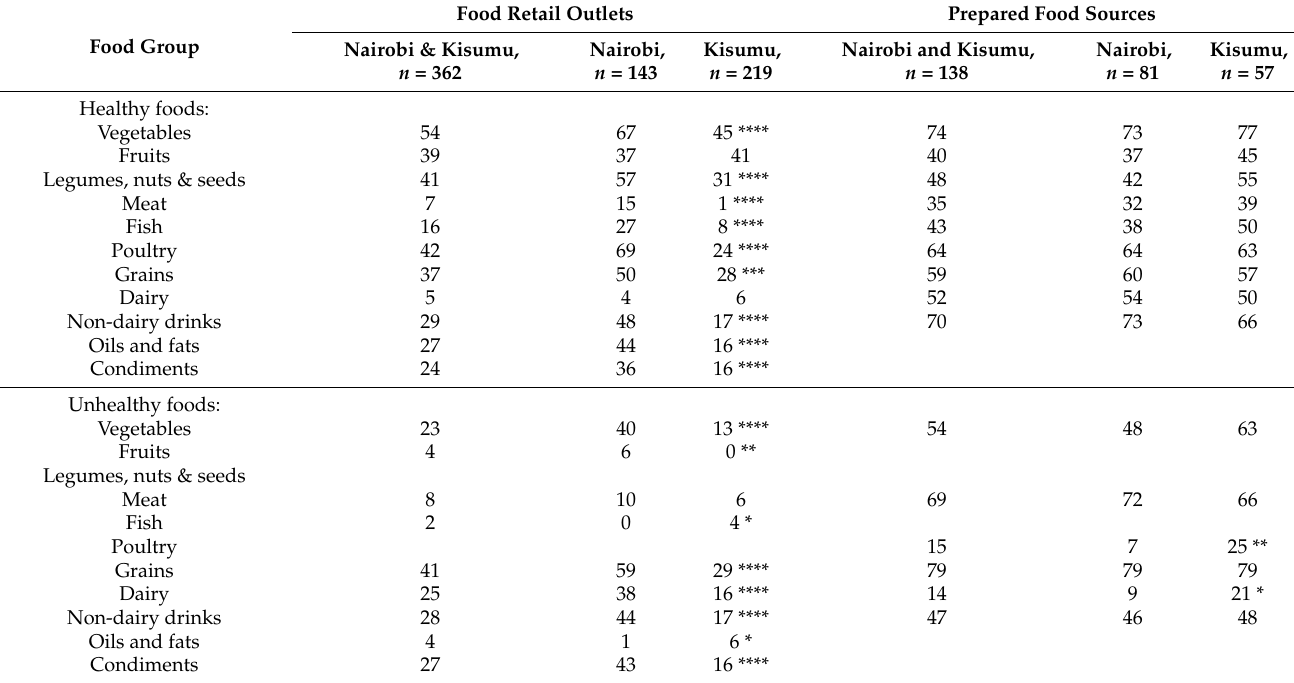
Table 4. Healthy and unhealthy food availability in food places near schools and neighborhoods (%) 1,2 .